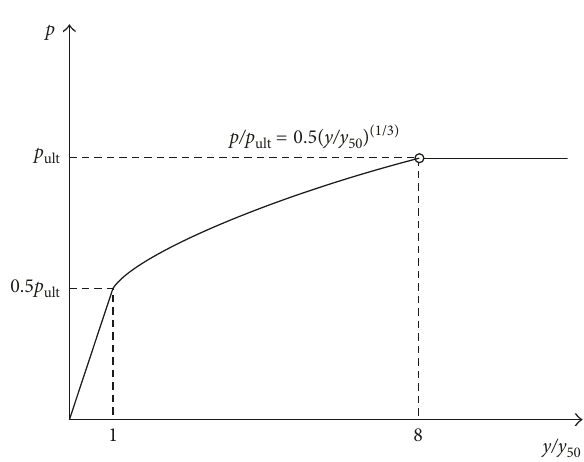
Figure 1: The p - y curve proposed by Matlock [9]. Figure 2: Hyperbolic p - y